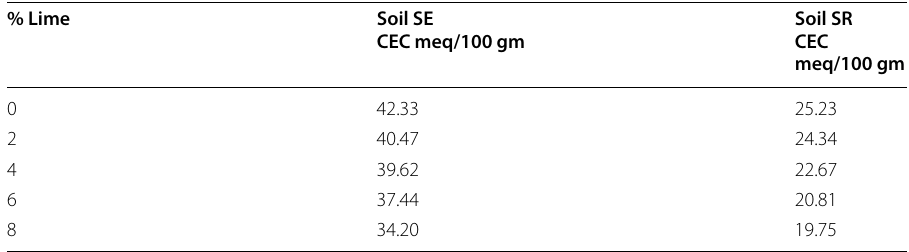
Table 5 Cation Exchange Capacity (CEC) for soils SE and SR %